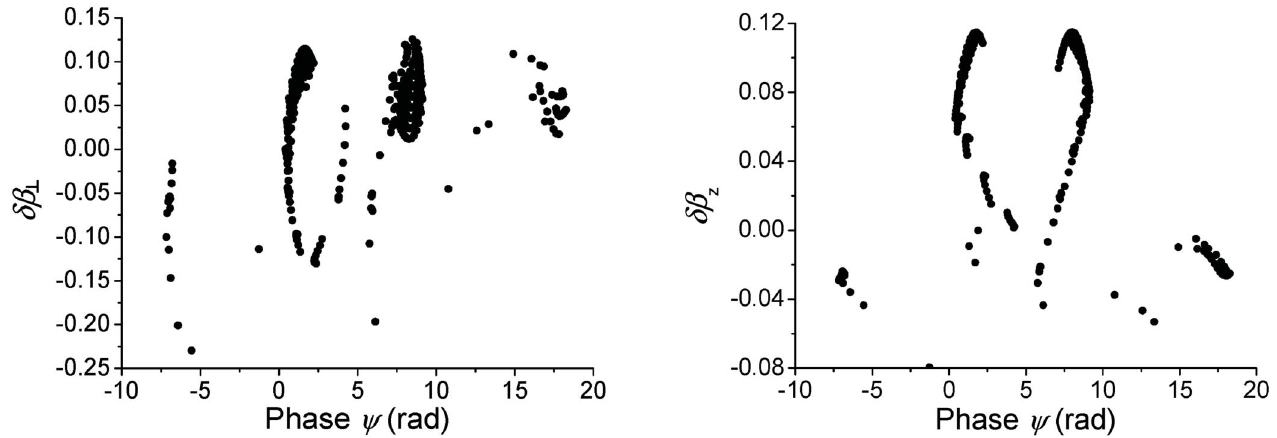
FIG. 2. Distributions of the perturbations of transverse and longitudinal velocities versus phase at z (cid:2) 135 cm from the entrance of the interaction region (for the initially single-wavelength section of the beam).